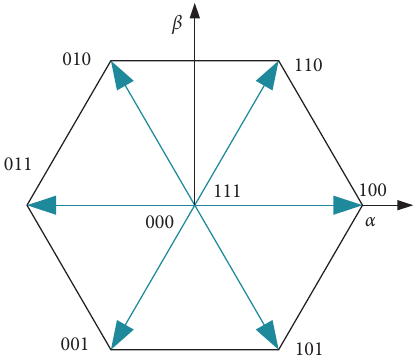
Figure 5: Eight groups of vectors of output.